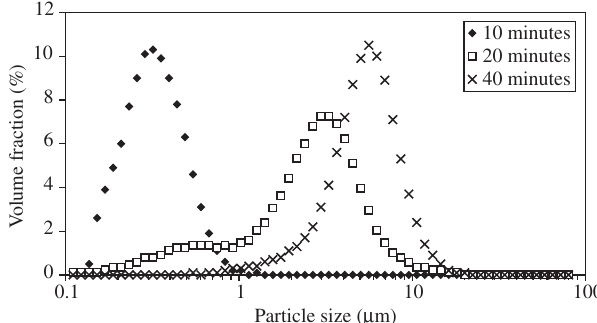
Figure 2. PSD curves of copper particles produced in Test 11, collected at different reaction